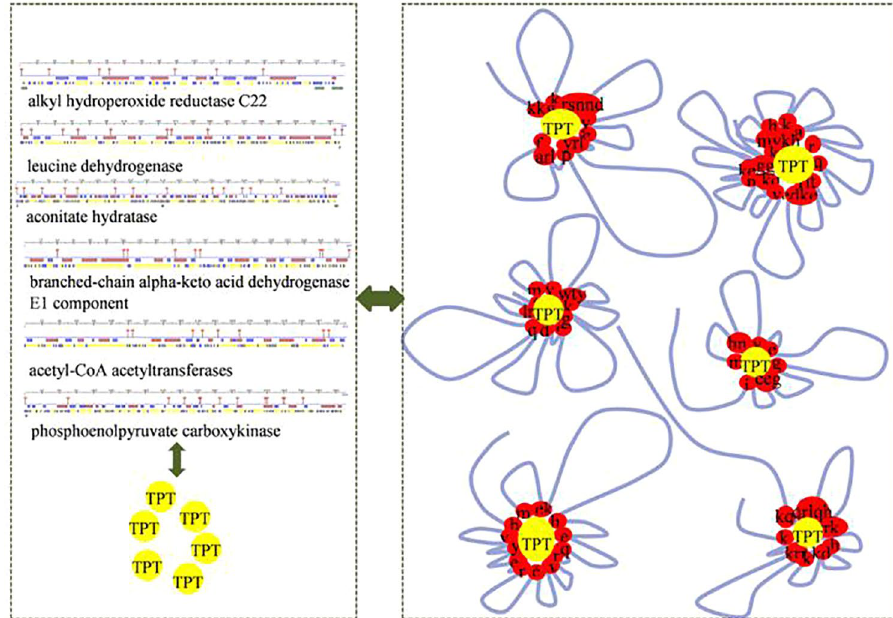
Figure 2. TPT recognition and combination by effector proteins in 2DE